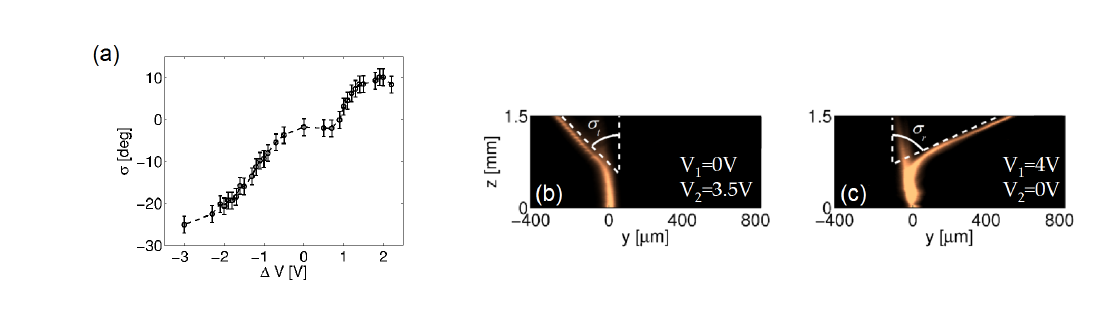
The overall deflection σ , plotted in Figure 11a for (cid:0) 3 V < ∆ V < 2 V ( i.e ., including transmission and total internal reflection), was about 35 (cid:14) . Such an angular range can be increased by tilting the input beam (wavevector), as shown in Figure 11b,c: for an input angle of (cid:25) 16 (cid:14) , we achieved an overall deflection (refraction angle σ plus reflection angle σ ) of about (cid:25) 55 (cid:14) , the largest nematicon steering to date in an t r electro-optically controlled arrangement [37]. Larger soliton deviations, reported at air-NLC interfaces, lacked tunability and/or voltage control